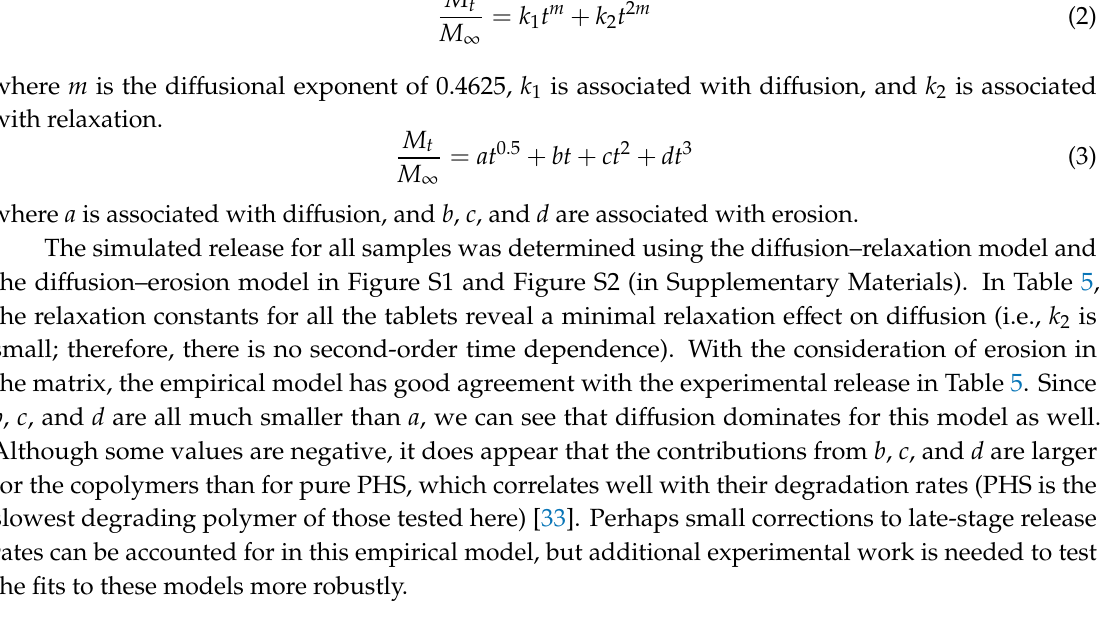
for 606-h release, and ( c ) PBHS 70/30_UP for 580-h release at 25 °C.